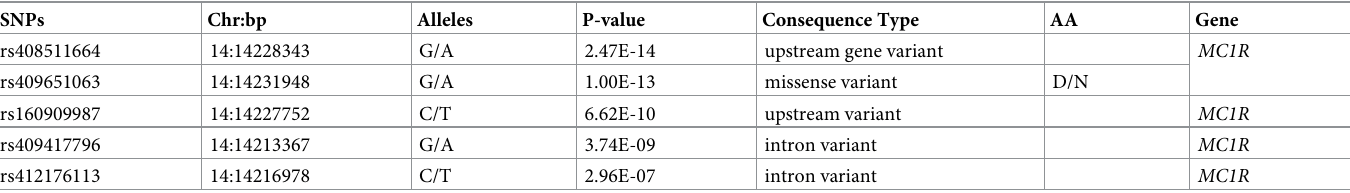
Table 2. GWAS results: genetic variants and their location, P -value, amino acid change and consequences.